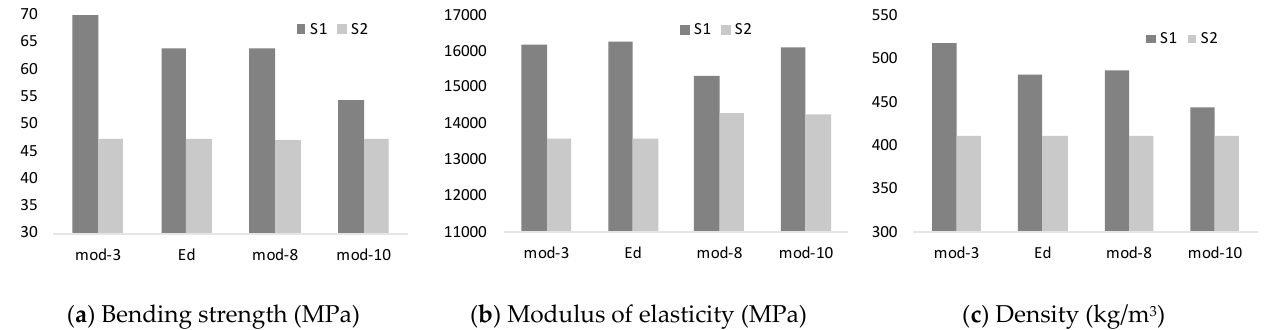
1 Strength class achieved without considering the reduction in the test results due to the factor k n of the EN 384 [26] to adjust to the number of subsamples.